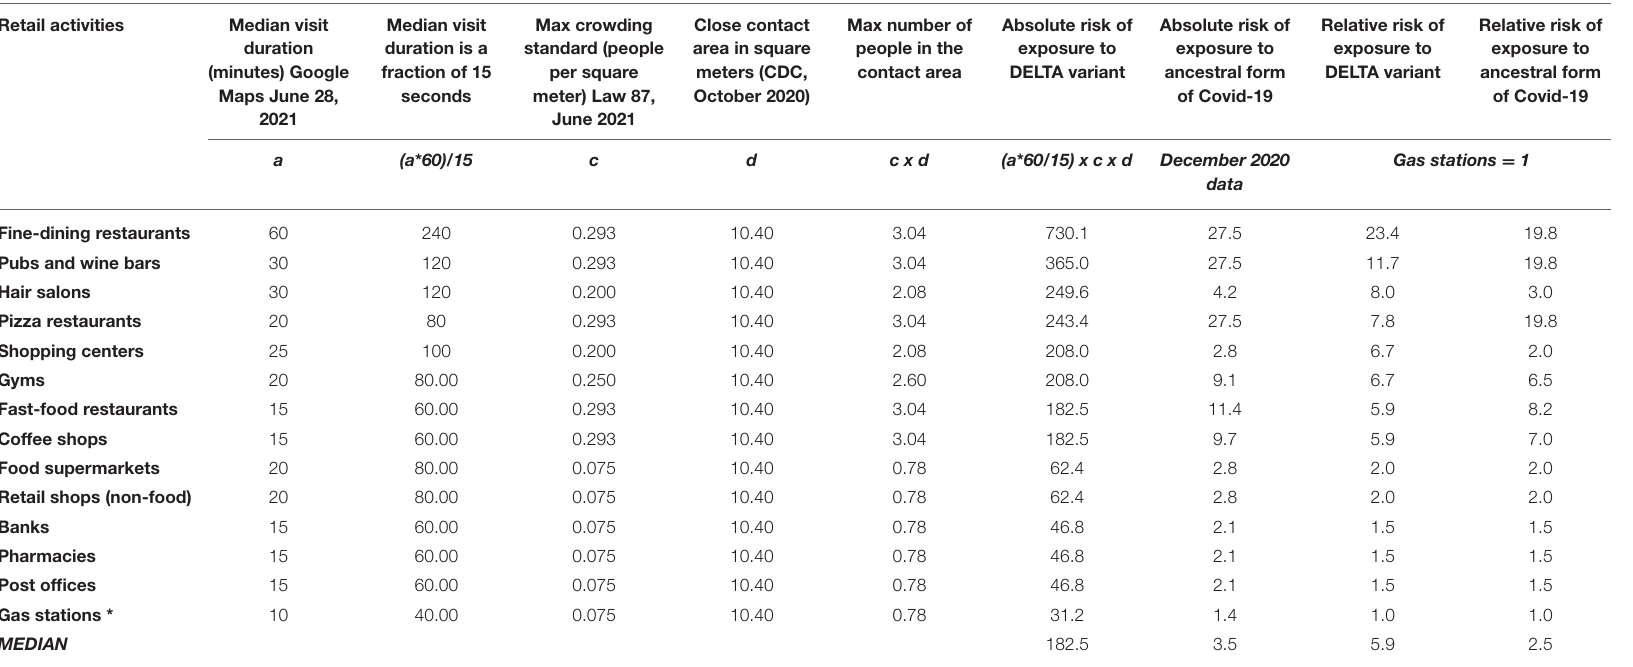
TABLE 3 | Absolute and relative risk of exposure to COVID-19 attributed to the Delta variant and the ancestral form of Covid-19 by retail